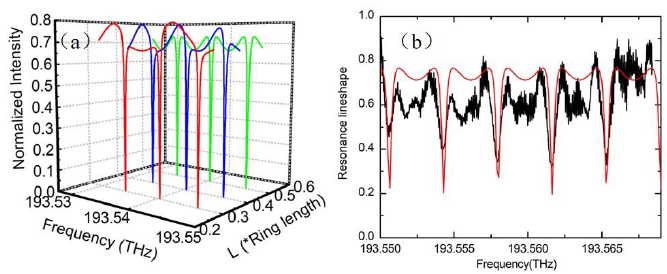
Figure 14. ( a ) Resonance characteristics of the intensity term I 3 with di ff erent straight waveguide length; ( b ) the measured resonance curve and the fitting results of the silicon nitride WRR.